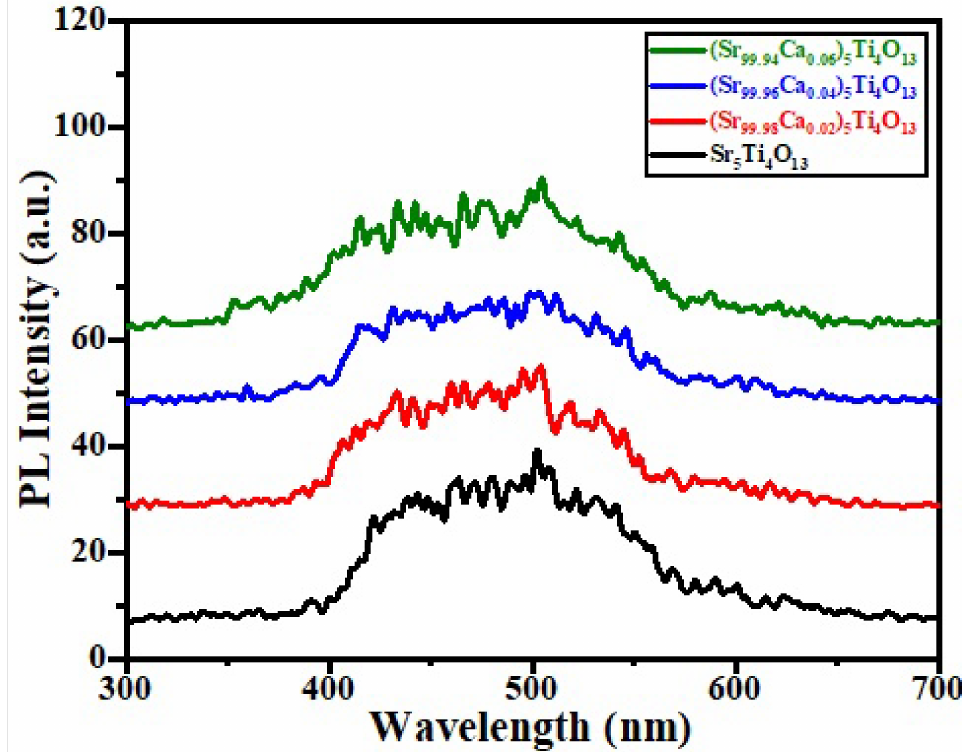
Figure 6. PL spectra of (Sr 1 − x Ca x ) 5 Ti 4 O 13 , 0.0 ≤ x ≤ 0.06